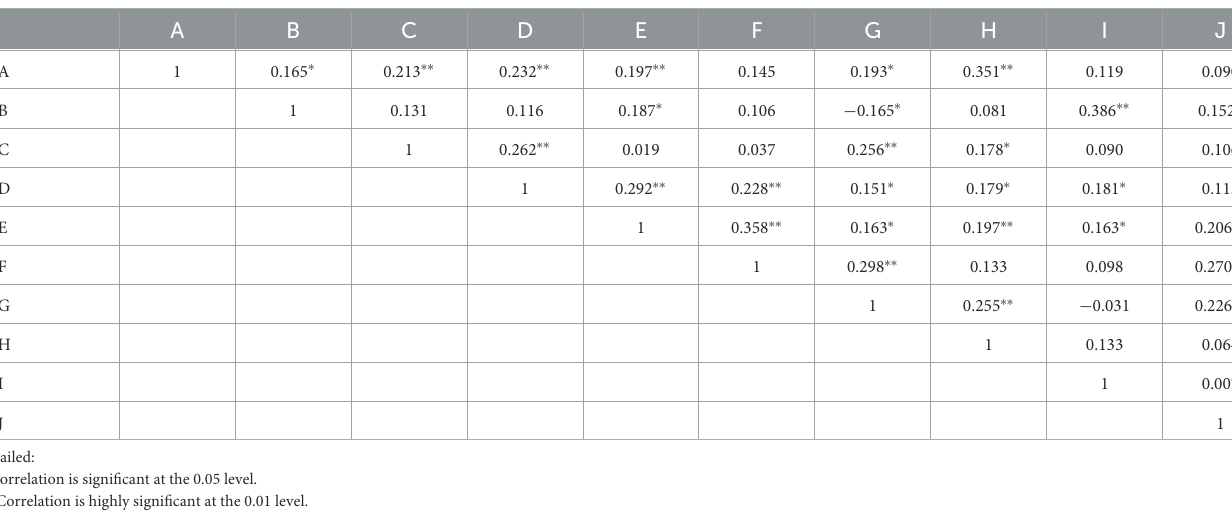
TABLE 7 Correlations (r) between the variables of reasons ( N =